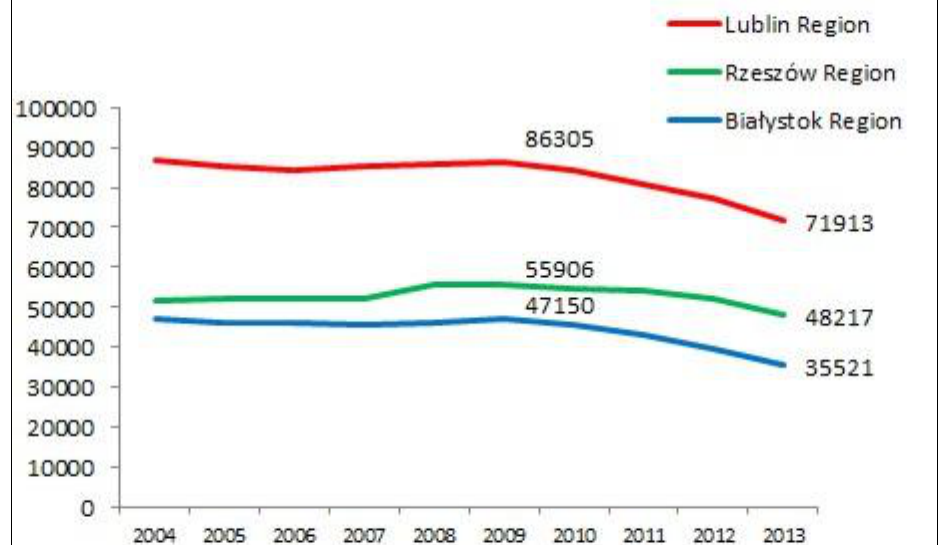
Fig. 11. Number of students in in Białystok, Lublin, and Rzeszów (2004-2013) (Local Data Bank of the Central Statistical Office)